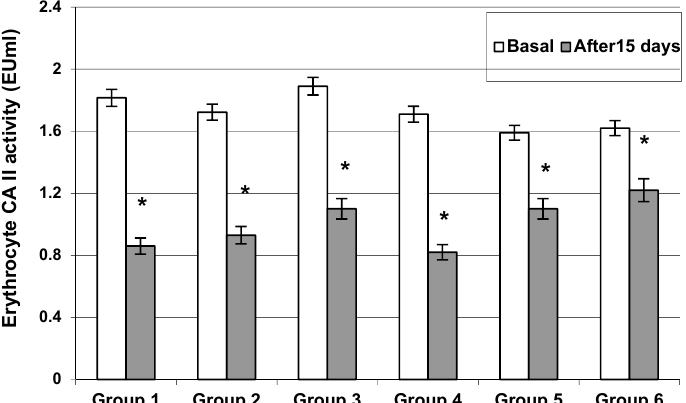
Figure 1. The inhibition of erythrocyte Carbonic Anhydrase II activity after 15 days of treatment with carbamazepine (Group 1), phenytoin (Group 2), valproate (Group 3), primidone (Group 4), clonazepam (Group 5), and ethosuximide (Group 6). Values are means ± SEM; n = 20 patients; * significant differences ( p < 0.05) after comparing values before treatment (paired t -test).